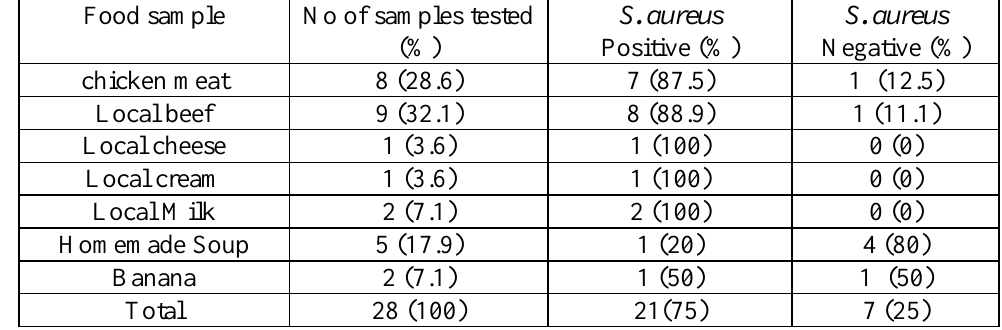
Table 1: Number and Percentage of Staphylococcus aureus Isolated from Food Samples. Food sample